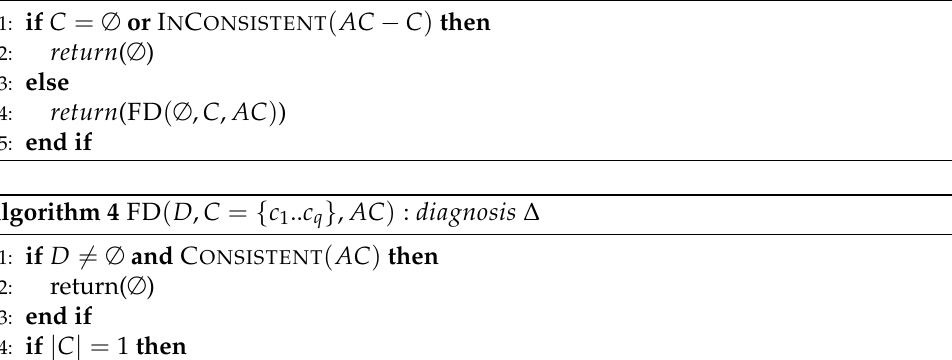
Algorithm 3 F AST D IAG ( C , AC ) : diagnosis ∆